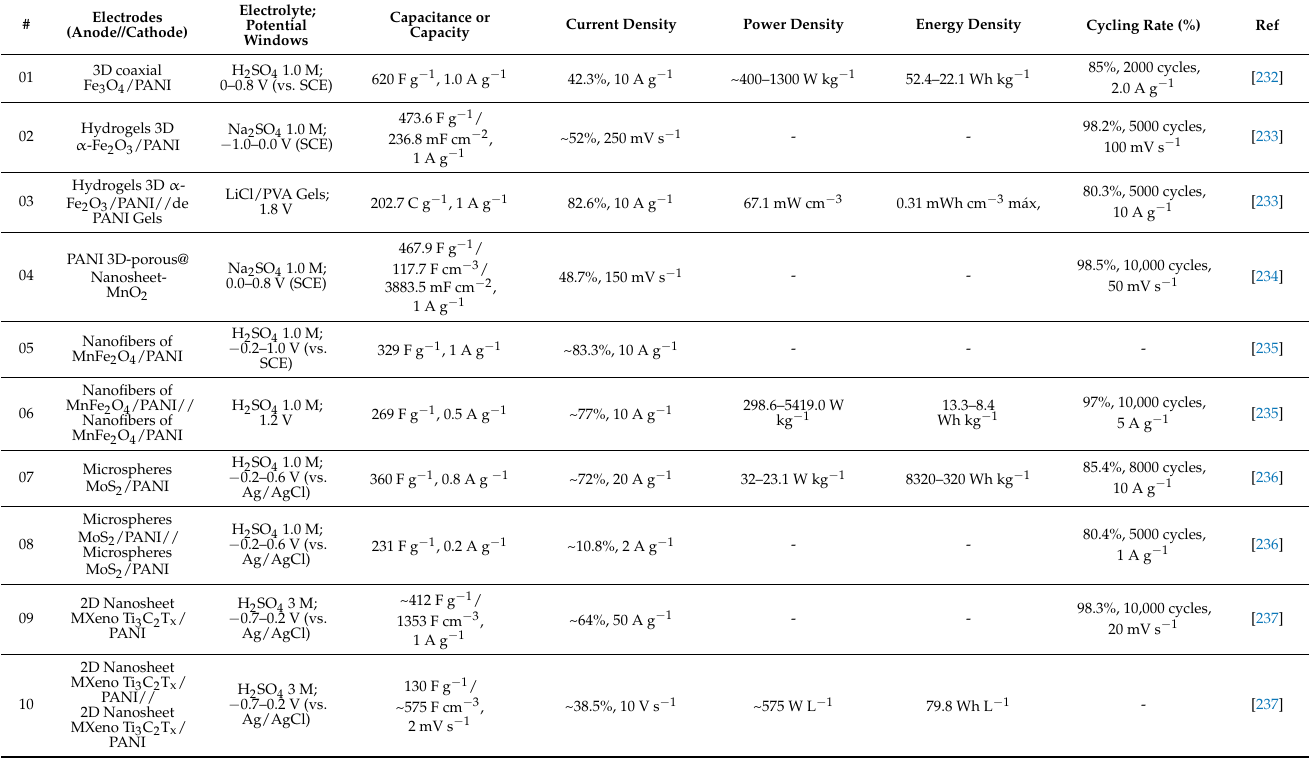
Table 2. Nanostructured PANI in various configurations, evaluated for supercapacitor electrodes, with their performance